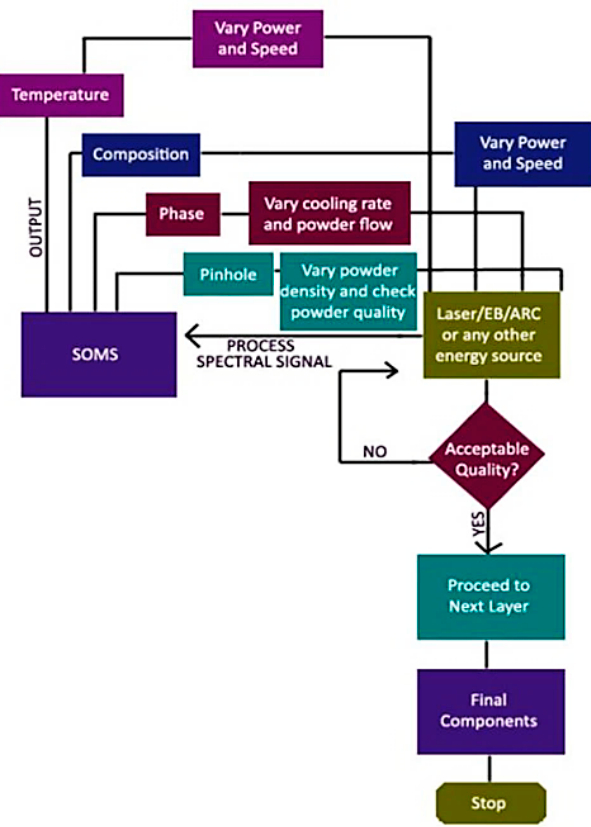
Figure 9. Flowchart for SOMS-based closed-loop control for AM [92].